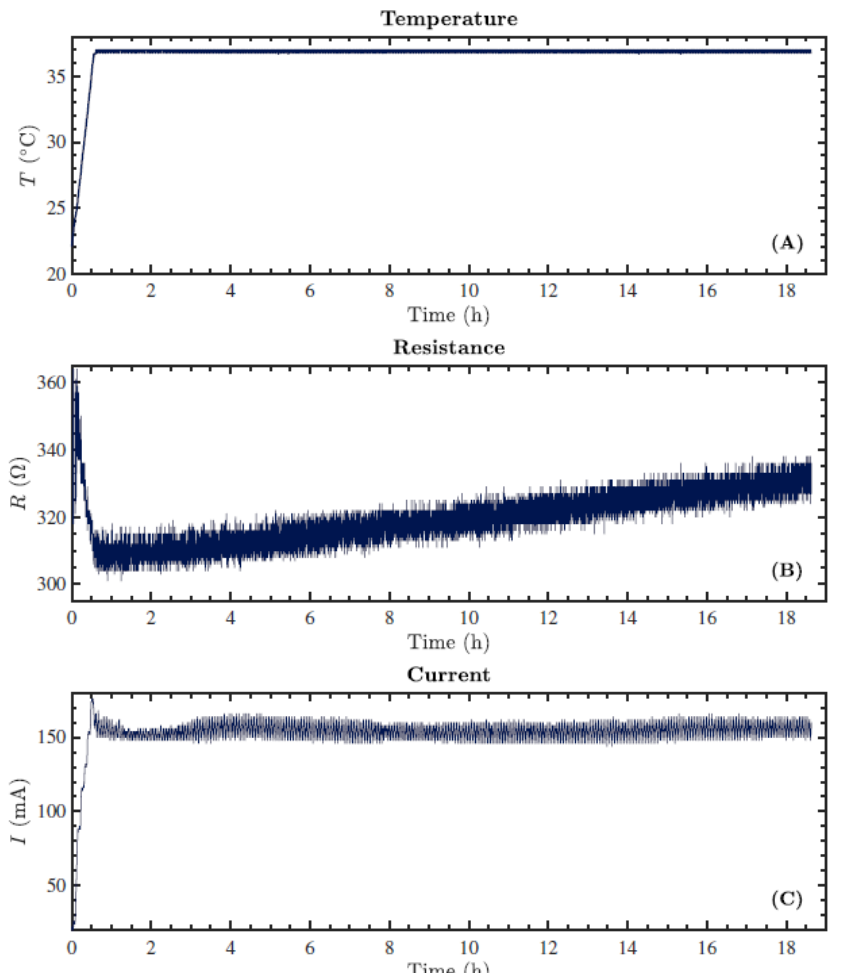
Figure 2. Representative graphs obtained from data logged every 3 s by the inovitro™ live throughout the exposure of HeLa cells to TTFields with the following parameters: a frequency of 100 kHz, the target medium temperature set to 37 ◦ C, a duty cycle of 1-1, and a duration of ~18 h. The ambient temperature was set to 23 ◦ C. ( A ) The measured temperature ( T ) as a function of time. ( B ) The measured resistance ( R ) as a function of time. ( C ) The measured current ( I ) as a function of ( I ) as a function of time.